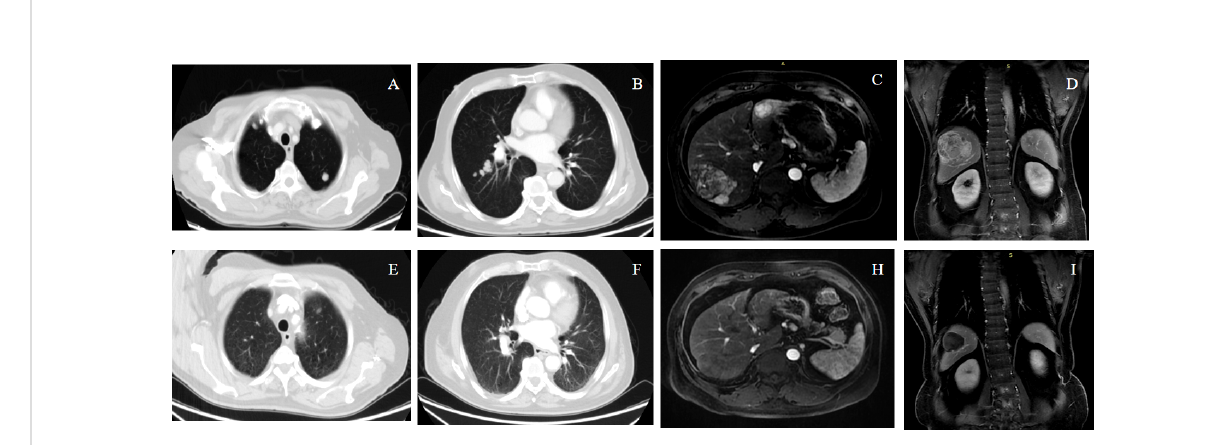
FIGURE 4 A 68-year-old male patient with advanced HCC with lung metastases achieved complete response (mRECIST) and partial response (RECIST1.1) after receiving atezolizumab plus bevacizumab combined with HAIC-FOLFOX. Panels (A – D) show the pre-treatment images, and Panels (E – I) show the